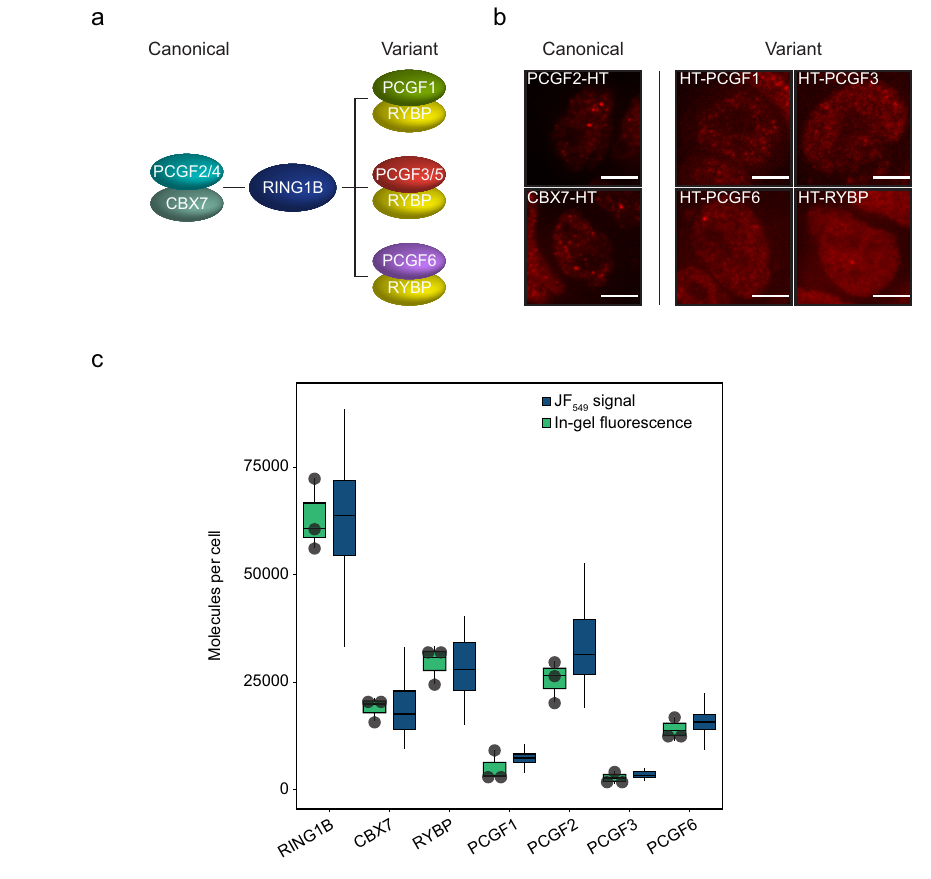
Fig. 5 PCGF2-PRC1 is the most abundant PRC1 complex in ESC. a A schematic illustrating the central canonical and variant PRC1 complexes. b Representative images showing a single Z-slice from ESCs expressing HaloTag fusions of PRC1 subunits labelled with JF 549 . Scale bar = 5 μ m. Imaging was performed in n = 2 biological replicates. c A box plot showing estimates of the number of protein molecules per cell, measured by in-gel fl uorescence (green), and corresponding measurements of relative JF 549 signal for PRC1 subunits (blue). Measured fl uorescence intensities have been converted into numbers of molecules by normalisation to the mean number of RING1B molecules per cell. Box plots indicate measurements for n > 35 cells (JF 549 signal) or n = 3 independent biological replicates of in-gel quanti fi cations (In-gel fl uorescence). The means for each replicate of in-gel fl uorescence measurements are represented by black dots. Boxes represent the interquartile range (IQR), the middle line corresponds to the median, and whiskers extend to the largest and smallest values no more than 1.5 x IQR from the box. Values outside of this range are not plotted, but are included in all analyses. Source data are provided as a Source Data fi